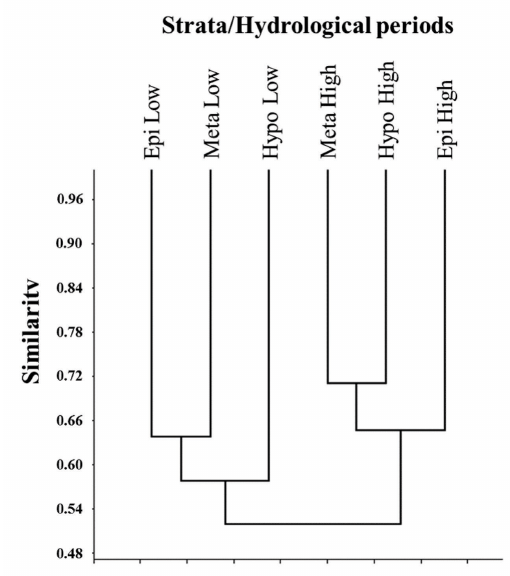
Figure 9. Cluster analysis based on ciliate species occurrence in distinct strata (Epi=epilimnion, Meta=metalimnion, Hypo=hypolimnion) in two hydrological periods (High water and Low water periods) at Guaraná Lake.